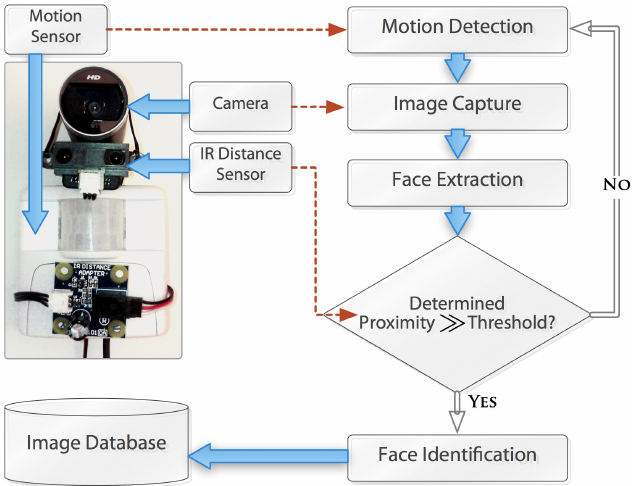
Figure 6. Camera and sensory device combos that were installed in four different locations in the test